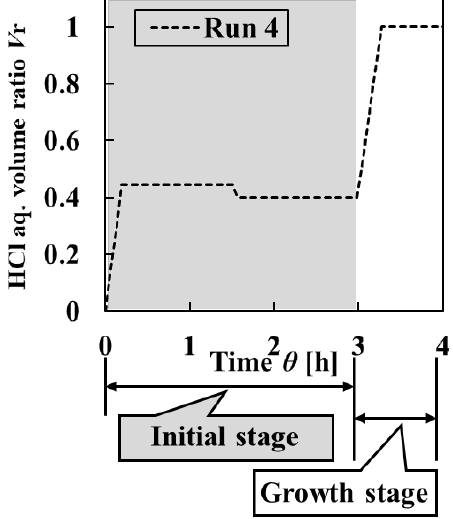
Figure 6. Change in HCl aq. volume ratio V r against the crystallization time in Run 4 with intermit- tent operation of HCl aq. with reverse addition of L-Asp aq.